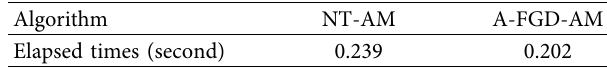
Table 2: Te elapsed times of these two algorithms.